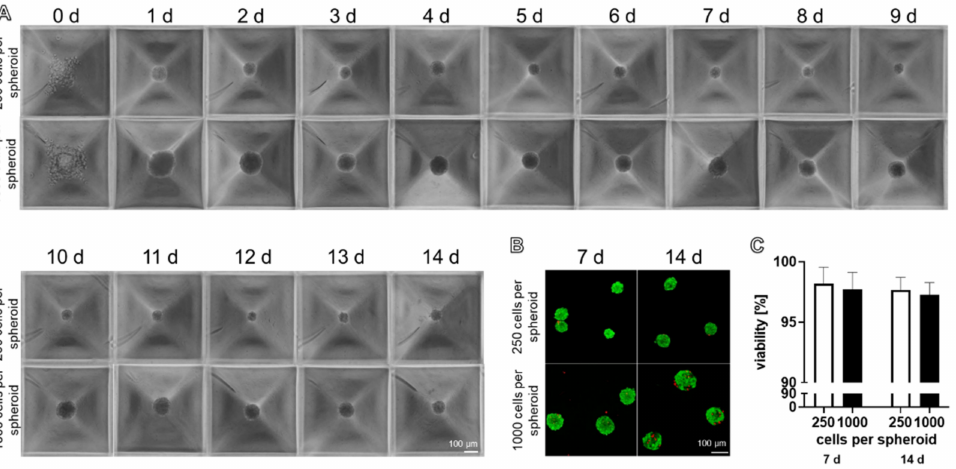
Figure 2. Ligamentocyte spheroid formation and viability based on 250 and 1000 cells per spheroid documented over 14 days using the spheroid plate. ( A ) Invert microscopical images of the spheroids within the micro cavities of the plates. ( B ) Viability of cells cultured in the spheroid plate at 7 and 14 days. Dead cells stained with propidium iodide are red and living cells metabolizing fluorescein diacetate are green. Scale bars: 100 µ m. ( C ) Viability was monitored by CLSM and calculated using ImageJ. Statistics: n = 5 independent experiments were performed with cells of five different donors. One-way ANOVA (Tukey’s multiple comparisons test) for comparison between groups ( C